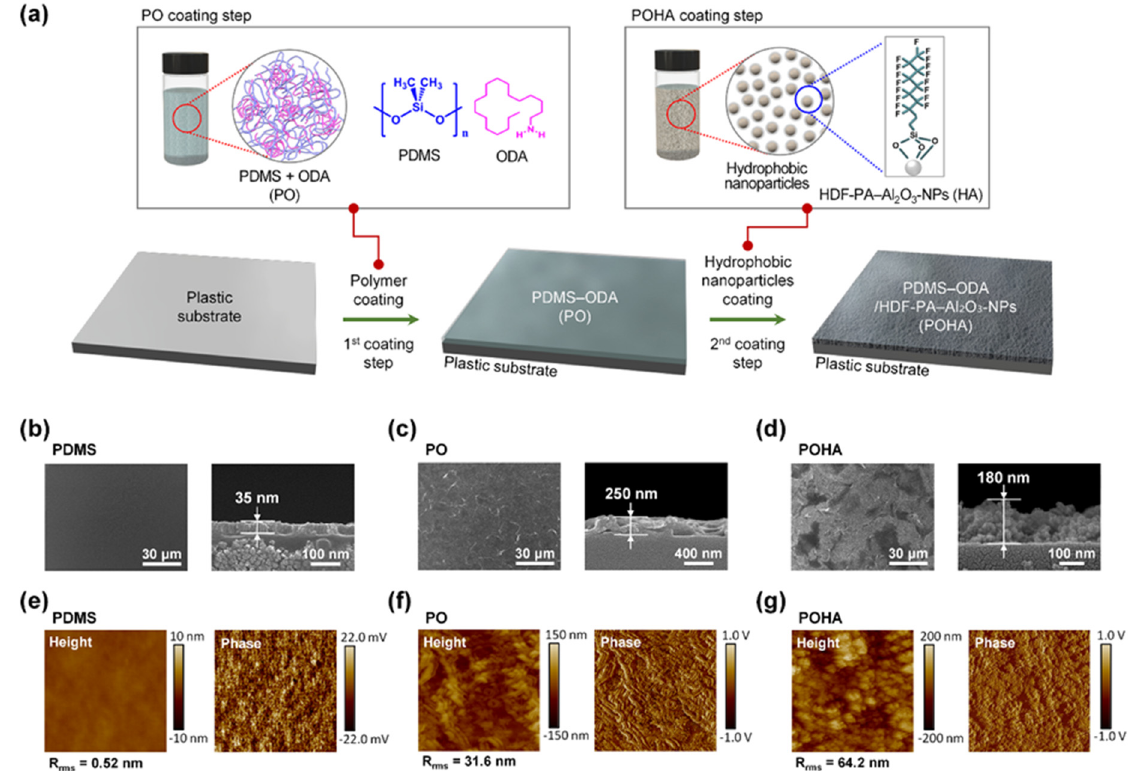
Figure 1. ( a ) Schematic of two-step coating method that can maintain high transparency while imparting hydropho-bicity to plastic substrates. Field-emission scanning electron microscopy (FE-SEM) images of the surfaces and cross sections of ( b ) polydimethylsiloxane (PDMS), ( c ) first coating (PO), and ( d ) second coating (POHA) formed on a polyethylene terephthalate (PET) substrate. Height- and phase-contrast atomic force microscopy (AFM) images (5 × 5 μ m 2 ) of ( e ) PDMS, ( f ) PO, and ( g ) POHA films formed on a PET substrate.